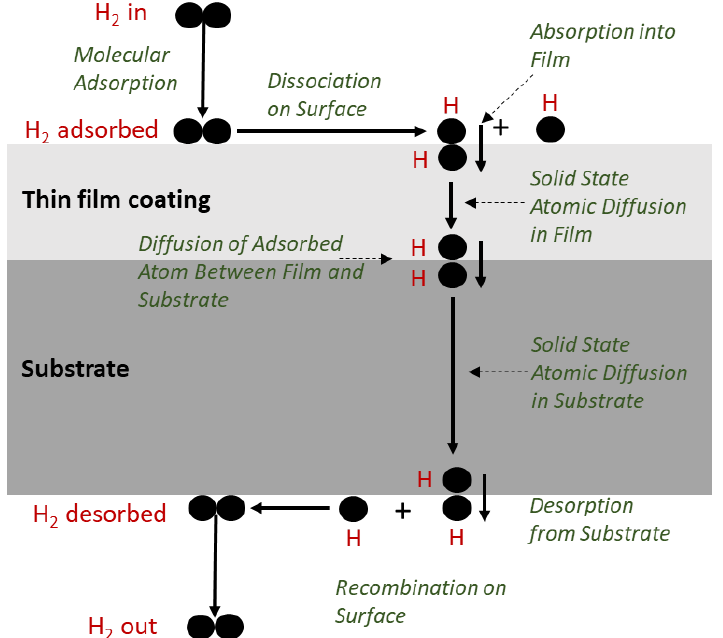
Figure 1. Illustration of hydrogen permeation in a thin film coated substrate; dissociation, adsorption on surface, diffusion in thin film coating, diffusion in substrate, recombination and desorption.